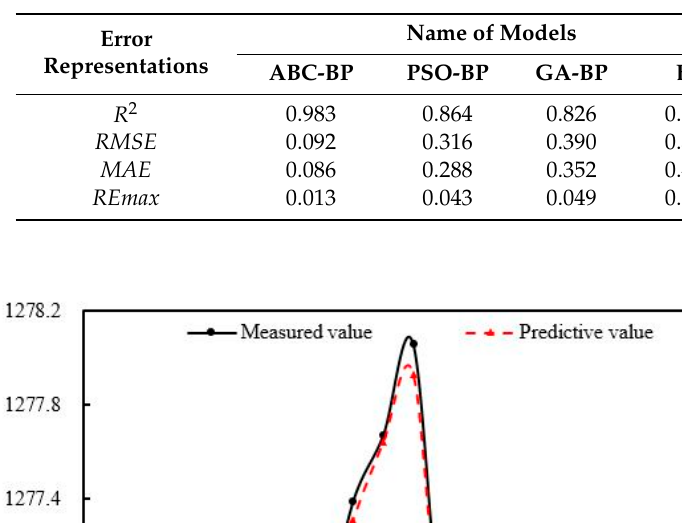
Table 3. Comparison of four error representations of the ABC-BP, PSO-BP, GA-BP, and BP models.